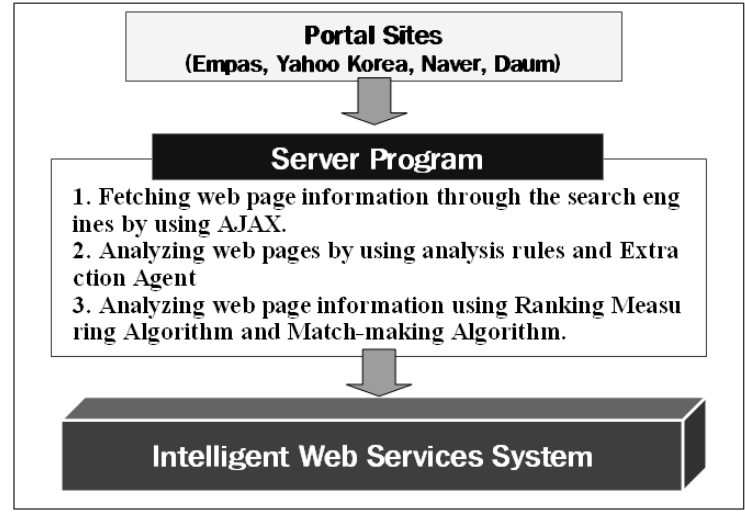
Figure 6. System Implementation method.